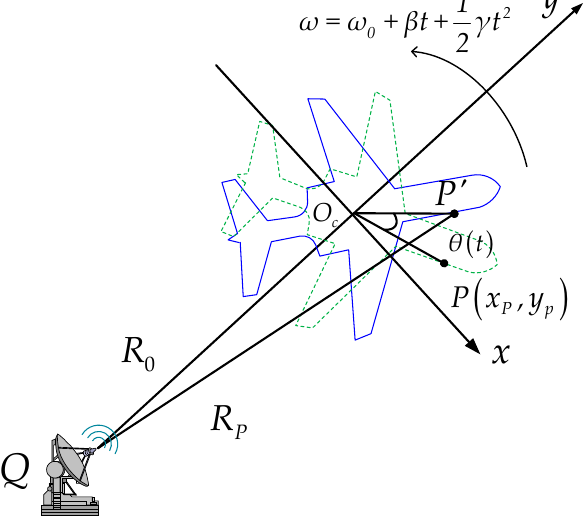
Figure 1. The ISAR imaging geometry for maneuvering target. With the Y axis along the radar line of sight (LOS), a cartesian coordinate XOY is established on the target, and the center of the revolving stage O c is determined as the origin of the coordinate. The distance from the origin to the radar is R P . Suppose